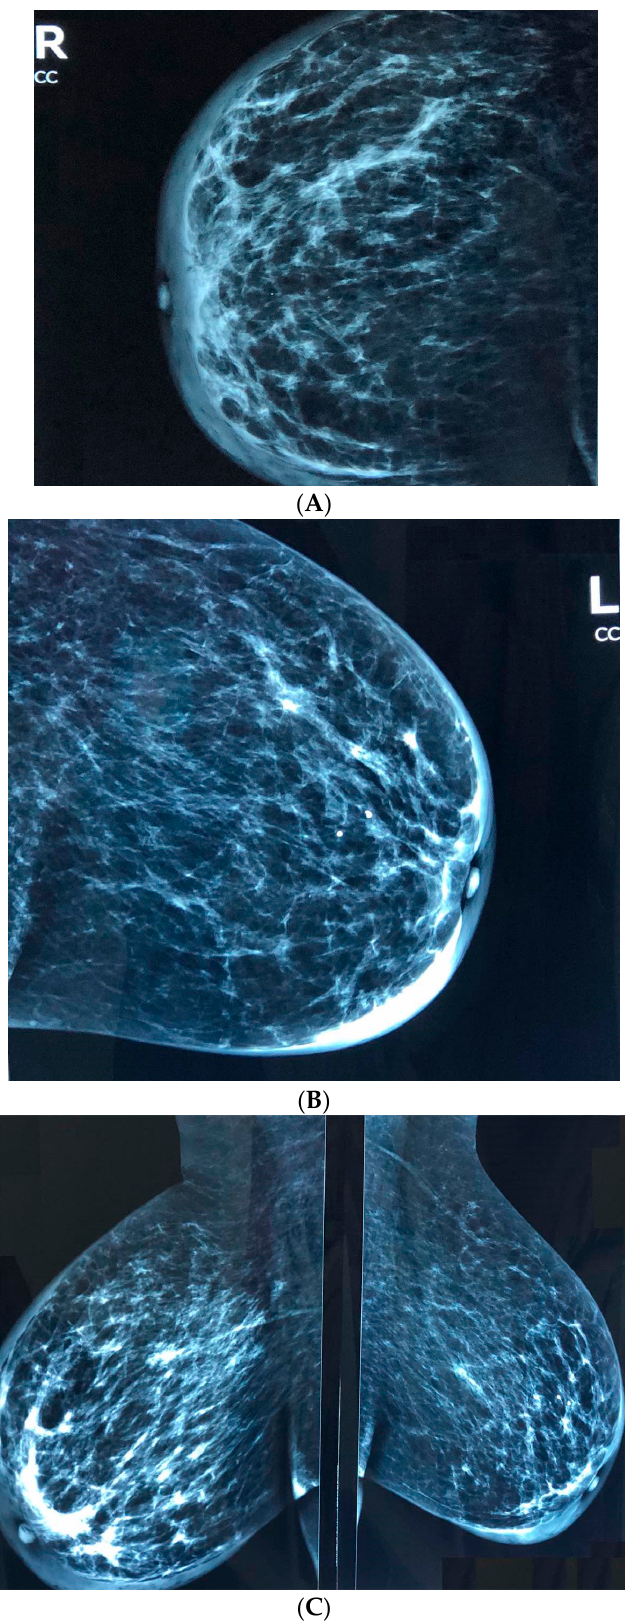
Figure 3. ( A ) . Cranial-Caudal (CC) mammogram view of the right breast without conclusive findings. ( B ) . Cranial-Caudal (CC) mammogram view of the left breast without conclusive findings. ( C ) . Medio-Lateral-Oblique (MLO) mammogram view of both breasts without conclusive findings.